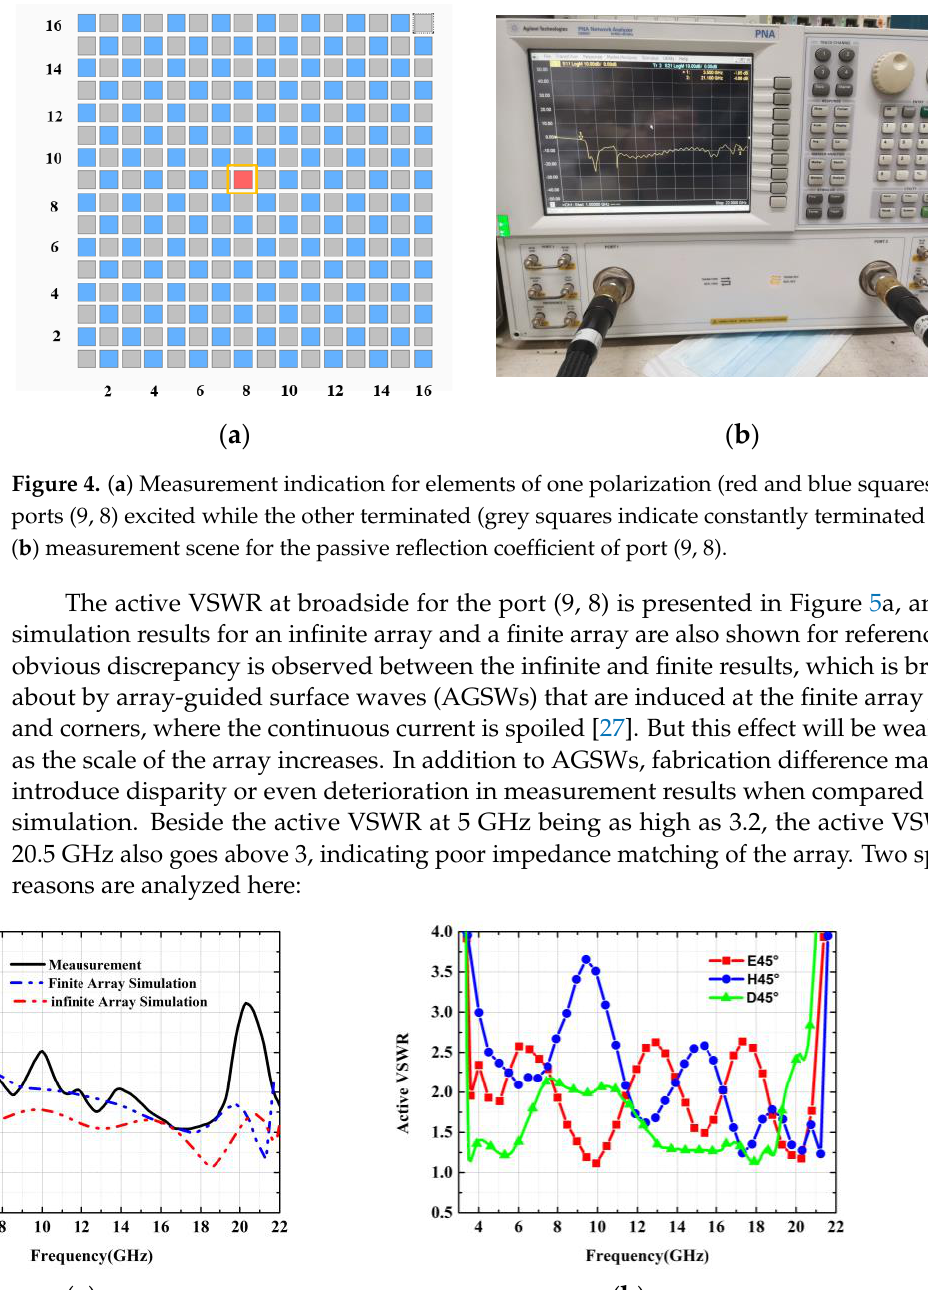
( b ) Figure 6. Pattern measurement of the central port ( a ) PUMA array in an anechoic chamber during PNT ( b ) excitation indication in a 256-port array. The active element pattern of the central region of a large array is very similar to that of an infinite array. Select ports (9,8) were selected to be excited while the other 255 ports were terminated, as seen in Figure 6b. The test results of the active element pattern at 4 GHz and 20 GHz in E/H planes are shown in Figure 7, while the simulation results are also given for comparison. ( a ) ( b )